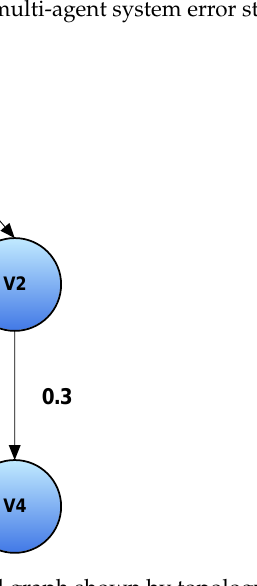
Figure 5. The leader–follower multi-agent system error states ω j ( τ ) .